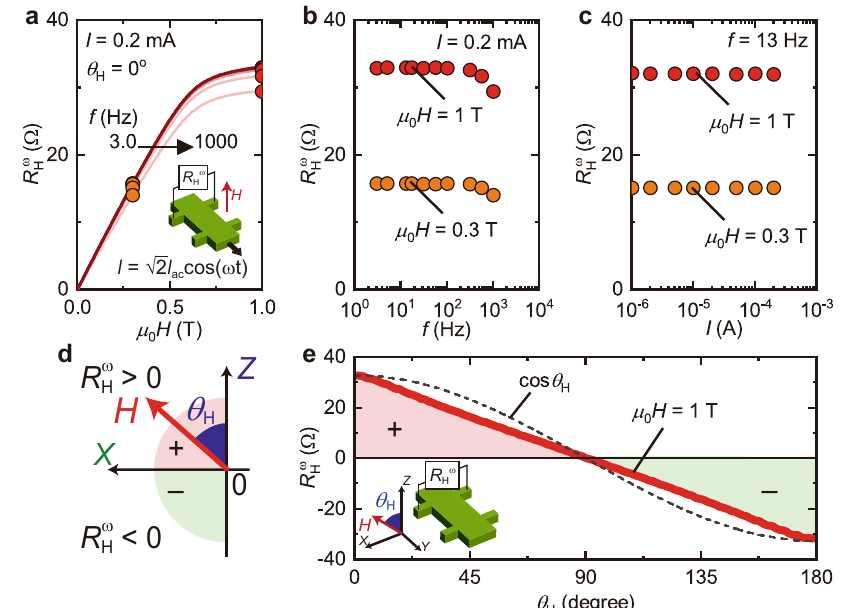
H ) measured at 0.2 mA 0 H = 0.3 and 1 T at μ H 0 produces a H H = 1 T. The H when μ H 0